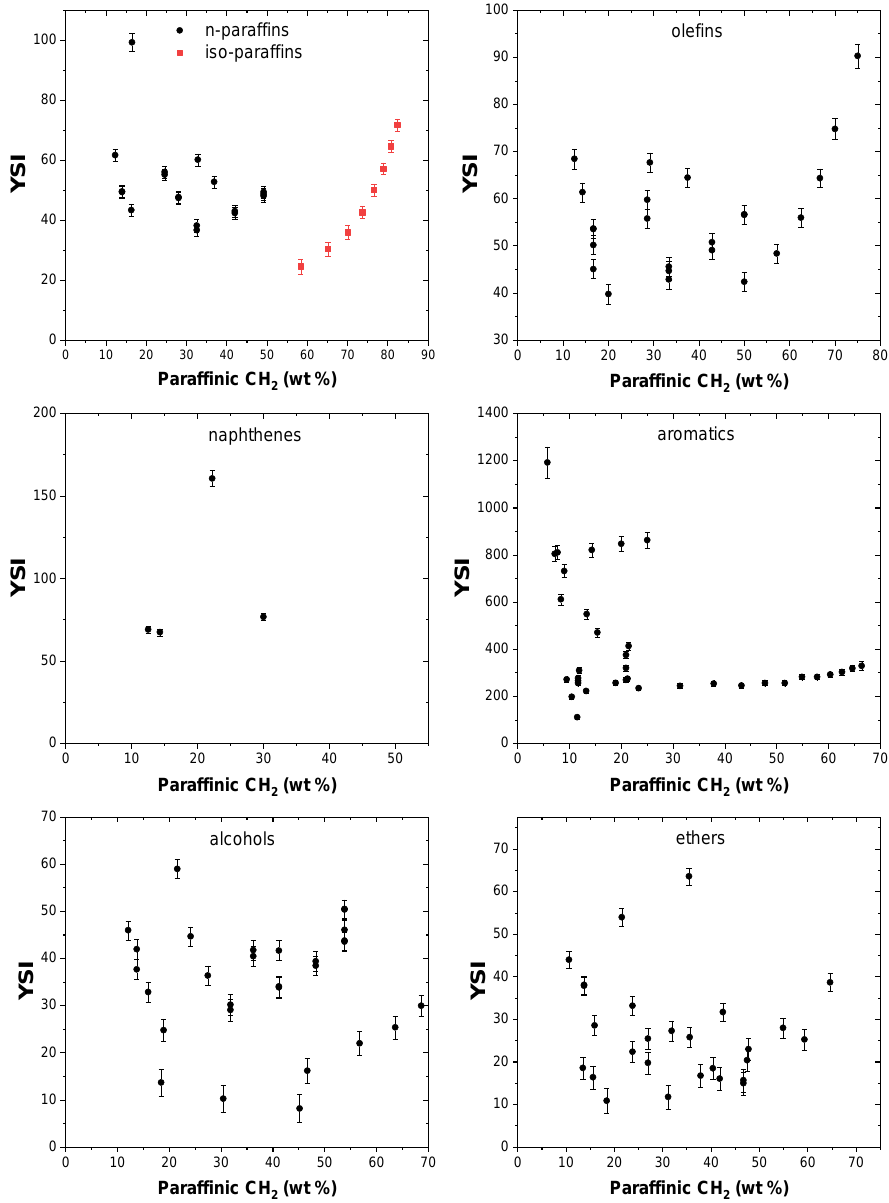
Figure 4. Effect of paraffinic CH 2 groups on YSI .